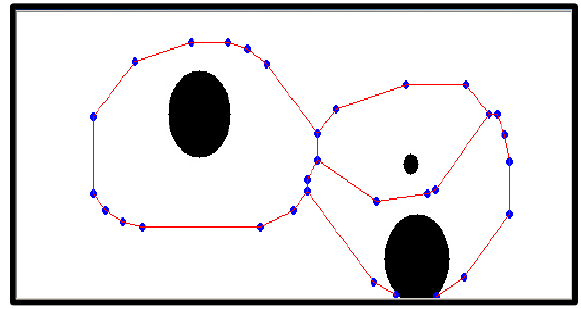
Figure 12. Topology map after applying the thinning algorithm.